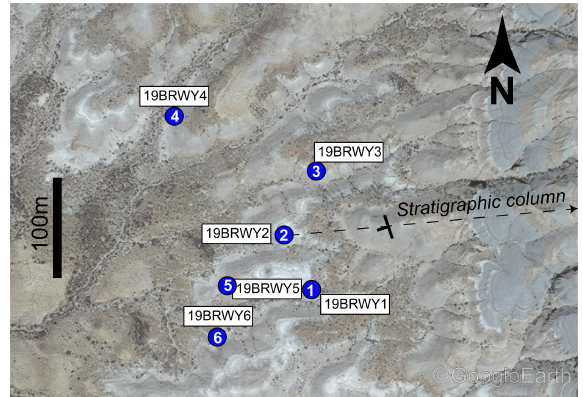
Figure 7. Lateral extent of paleosols. Included are paleosols 19BRWY1-6 atop an image of the Blue Rim escarpment topography with a 100m scale bar. Paleosol numbers are noted in white text on blue circles. Image taken in Google Earth V 9.123.0.2 (July 2019) in Wyoming, USA; 41 ◦ 48 (cid:48) 02 (cid:48)(cid:48) N, 109 ◦ 35 (cid:48) 36 (cid:48)(cid:48) W; eye altitude 2625m. © Google